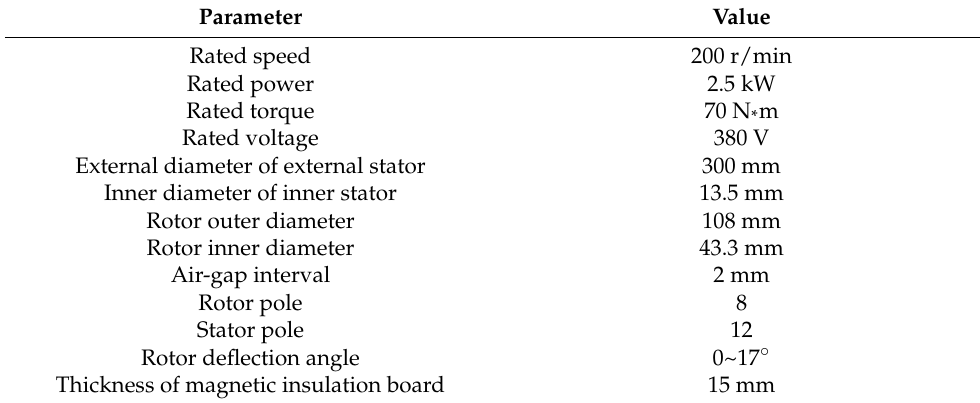
Figure 2. Overall structure distribution of DDSRG.